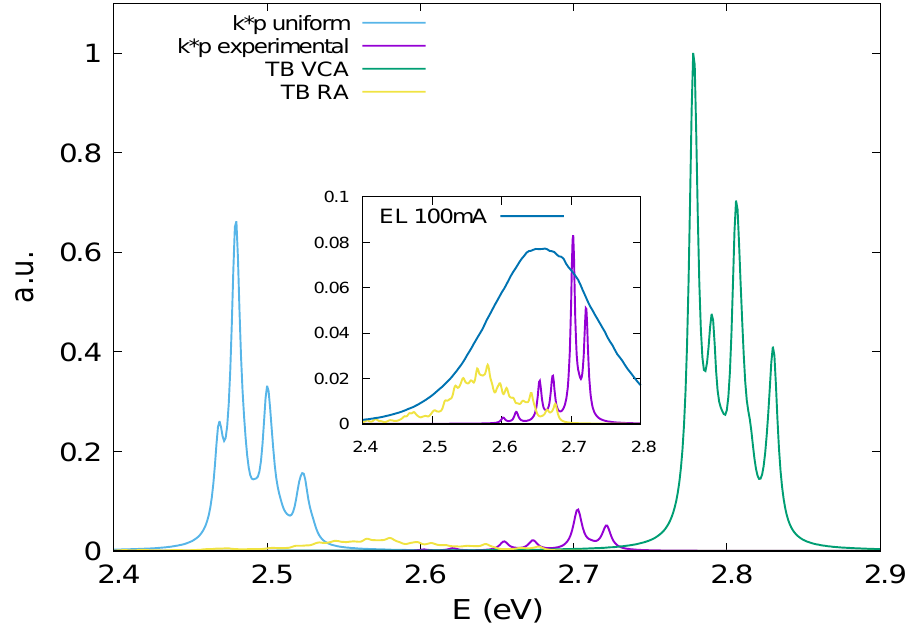
Figure 5. Optical strengths as a function of optical transition energy given by the (cid:126) k · (cid:126) p models with uniform and real In content distributions and by the ETB approach with VCA and RA composi- tion